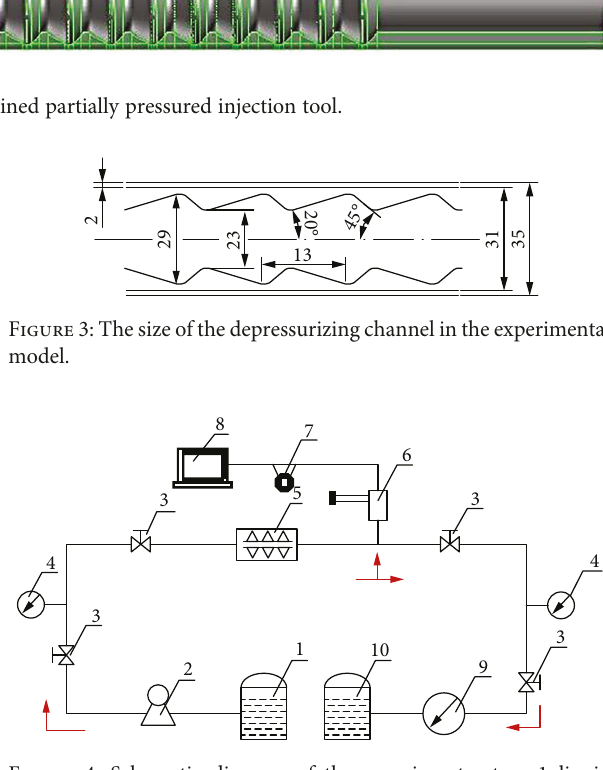
Figure 4: Schematic diagram of the experiment setup. 1 liquid storage tank, 2 screw pump, 3 valve, 4 pressure gauge, 5